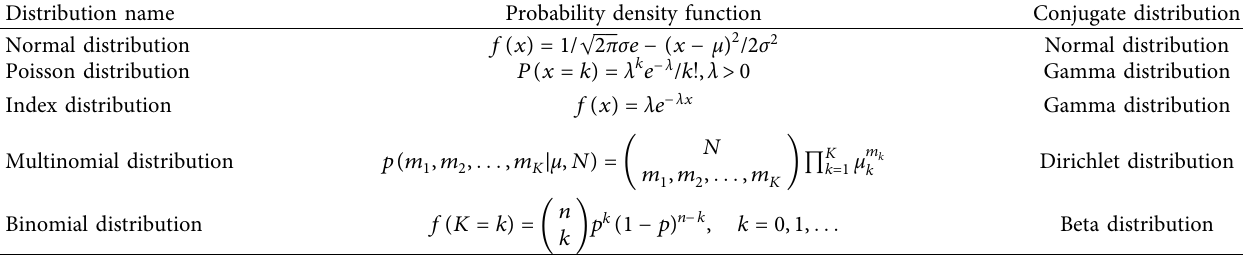
Table 1: Probability density functions of common distributions and their conjugate